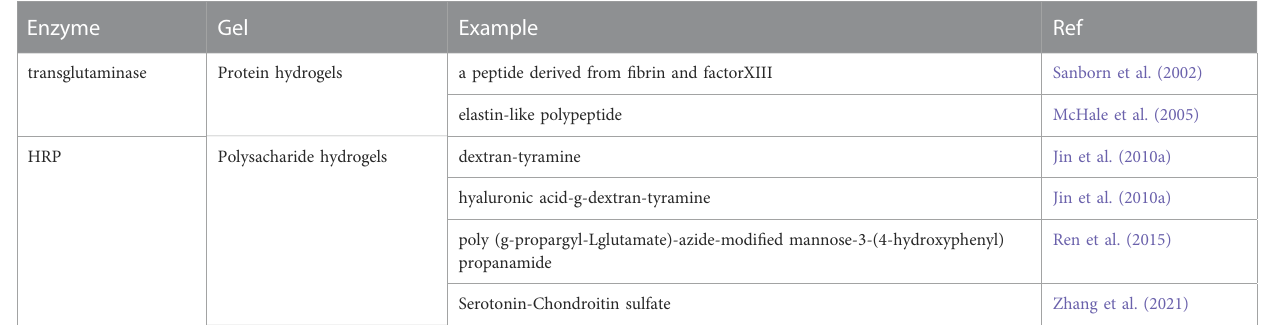
TABLE 1 Examples of gels formed by enzymes in the literature. Enzyme